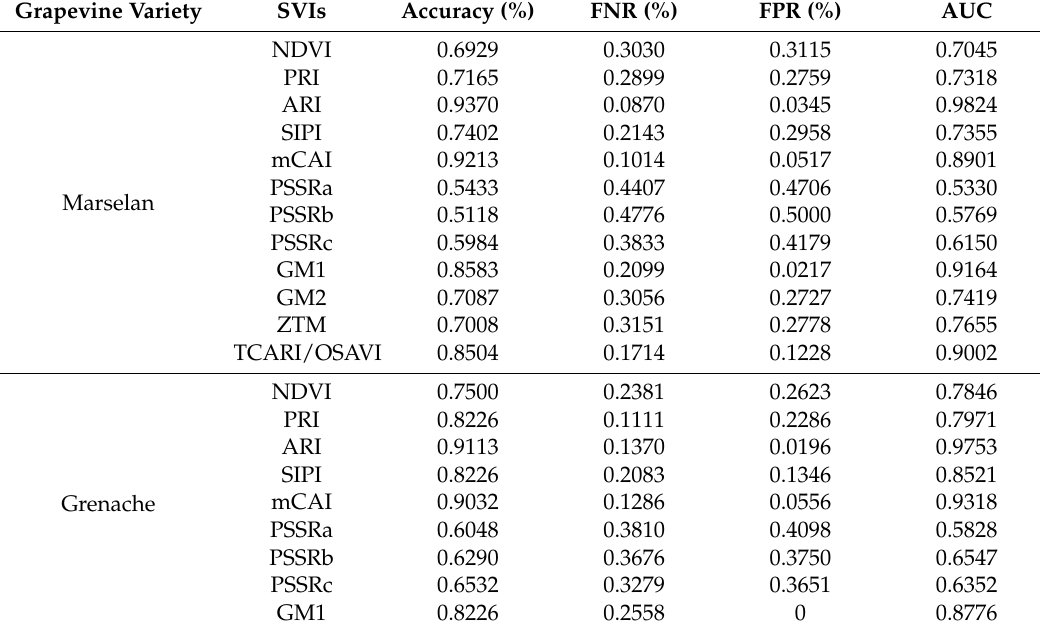
Table A3. Results of SVIs in classifying different groups of spectral data acquired in the August and the September acquisition campaigns (Severity of infestation = 1 &